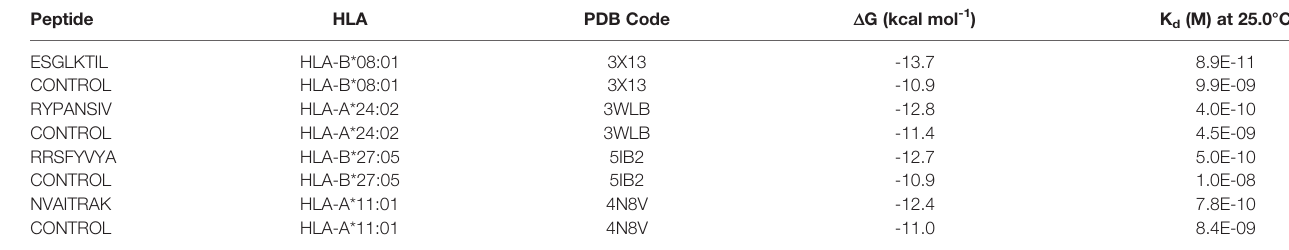
TABLE 2 | The binding energy between the modeled peptides and the HLA molecules. Peptide HLA PDB